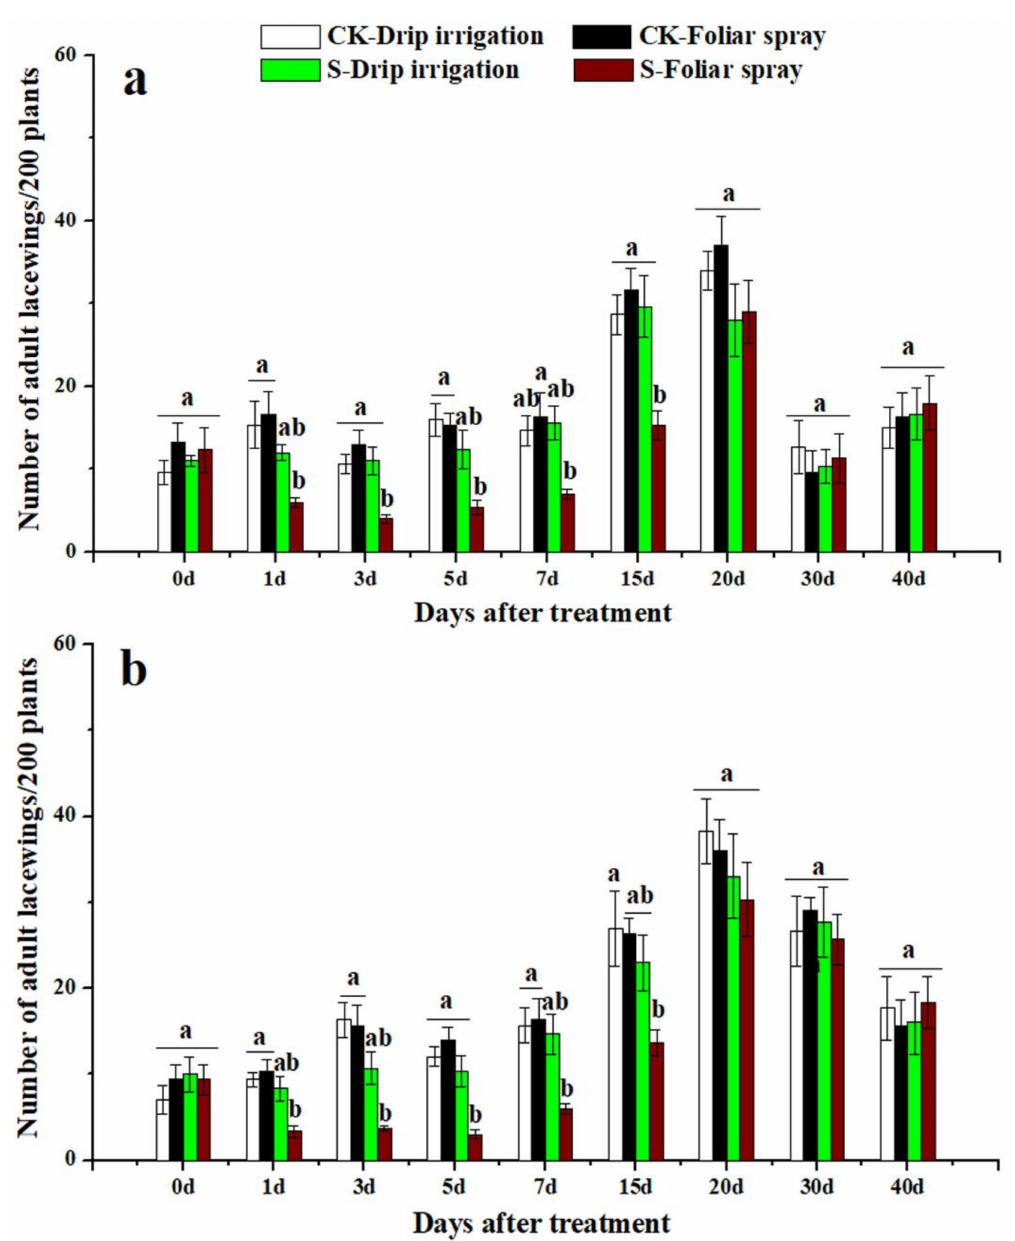
Figure 5. The numbers of adult lacewings on cotton plants not treated with any chemical (CK-Drip irrigation and CK-Foliar spray) and treated with sulfoxaflor through drip irrigation (S-Drip irrigation) and foliar spray (S-Foliar spray) in 2016 ( a ) and 2017 ( b ). All data are expressed as mean ± S.E. (n = 3). Values within the same time period labeled with di ff erent letters are significantly di ff erent based on Tukey’s HSD test at p <